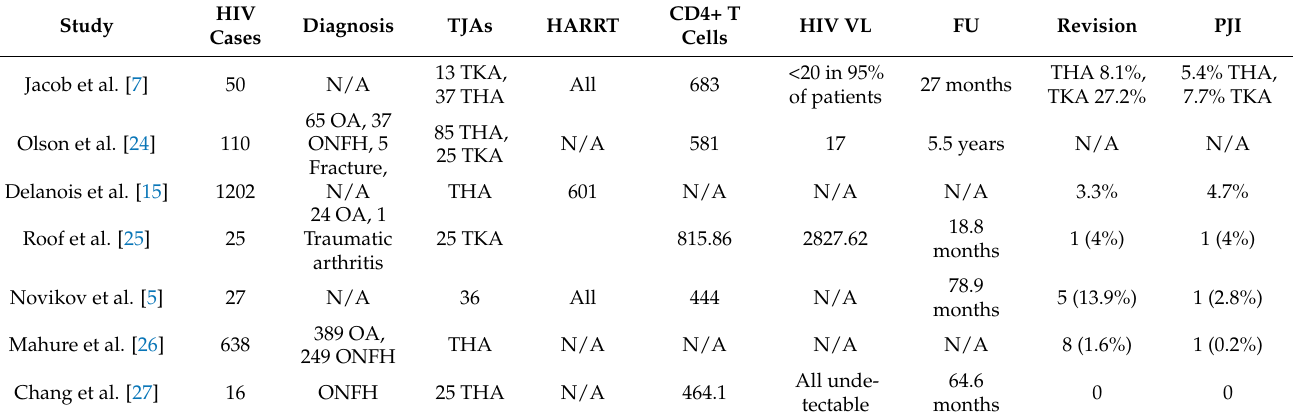
Table 3. THA surgeries performed in HIV patients as reported in the